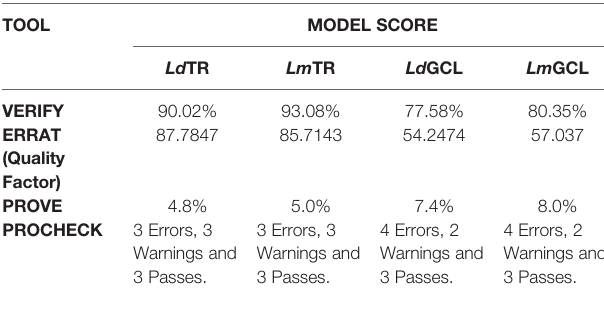
TABLE 2 | Model Evaluation of the Selected Models using various tools.